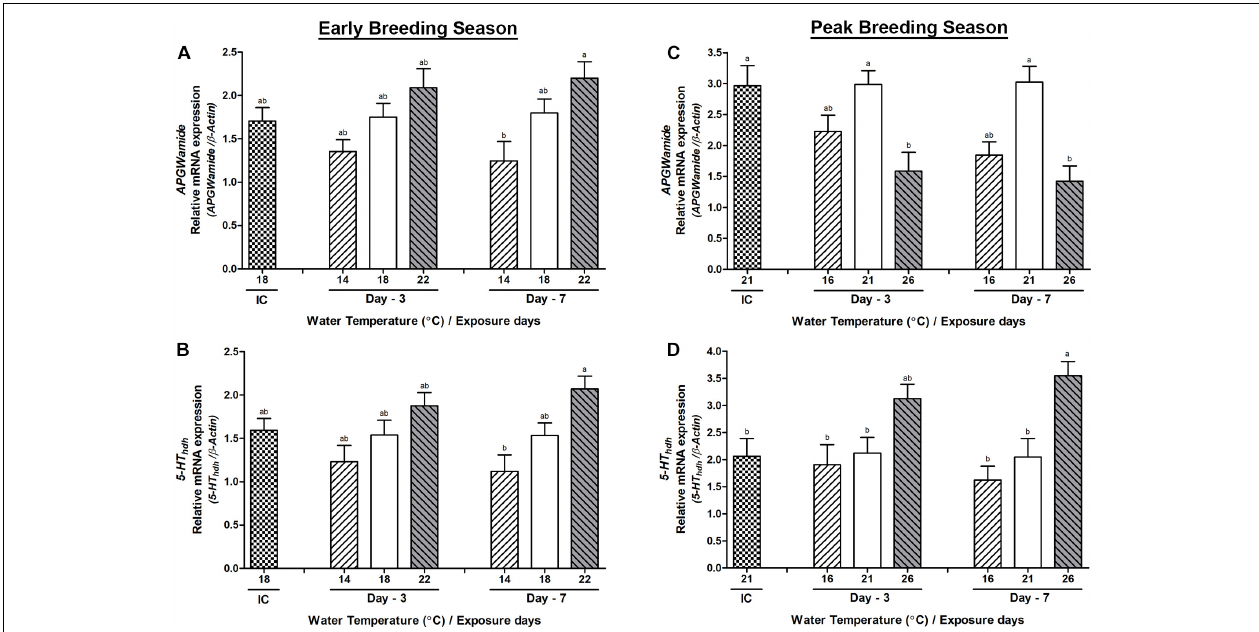
FIGURE 9 | Changes in the relative mRNA expression of Hdh-APGWamide (A,C) and 5-HT hdh (B,D) in the testis of male Pacific abalone during early and peak breeding seasons after exposure to thermal stress for 7 days. Before exposure to the target temperature of thermal stress, abalone were sampled to obtain reference values that served as initial control (IC). Values represent the mean ± SD ( n = 10). Different letters on the bar indicate significant differences among different temperature groups ( p < 0.05).